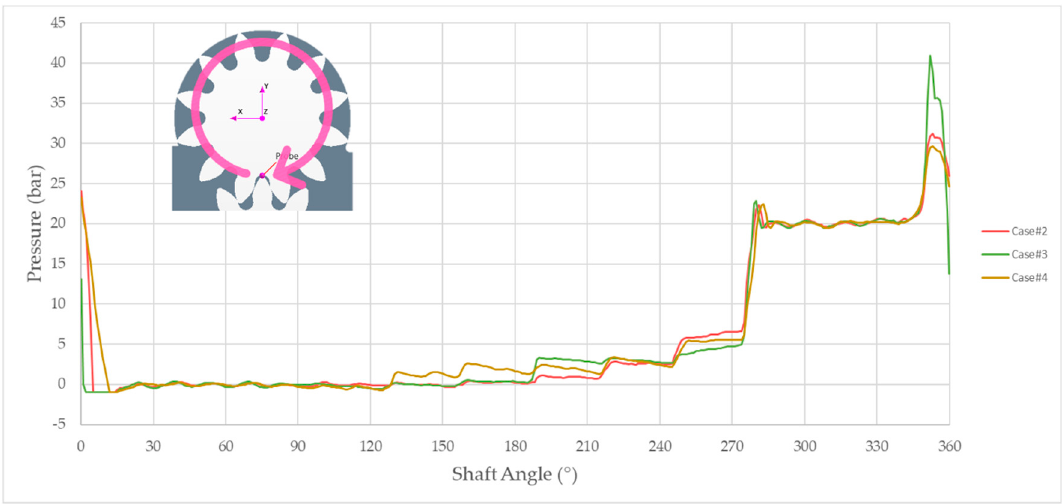
Figure 22. Pressure within a displacement chamber of the pump during an entire revolution of the driving shaft for Case #2, Case #3, and Case #4.